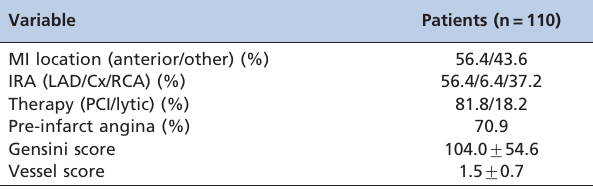
Table 2 - Clinical and angiographic characteristics of the patients with acute STEMI.